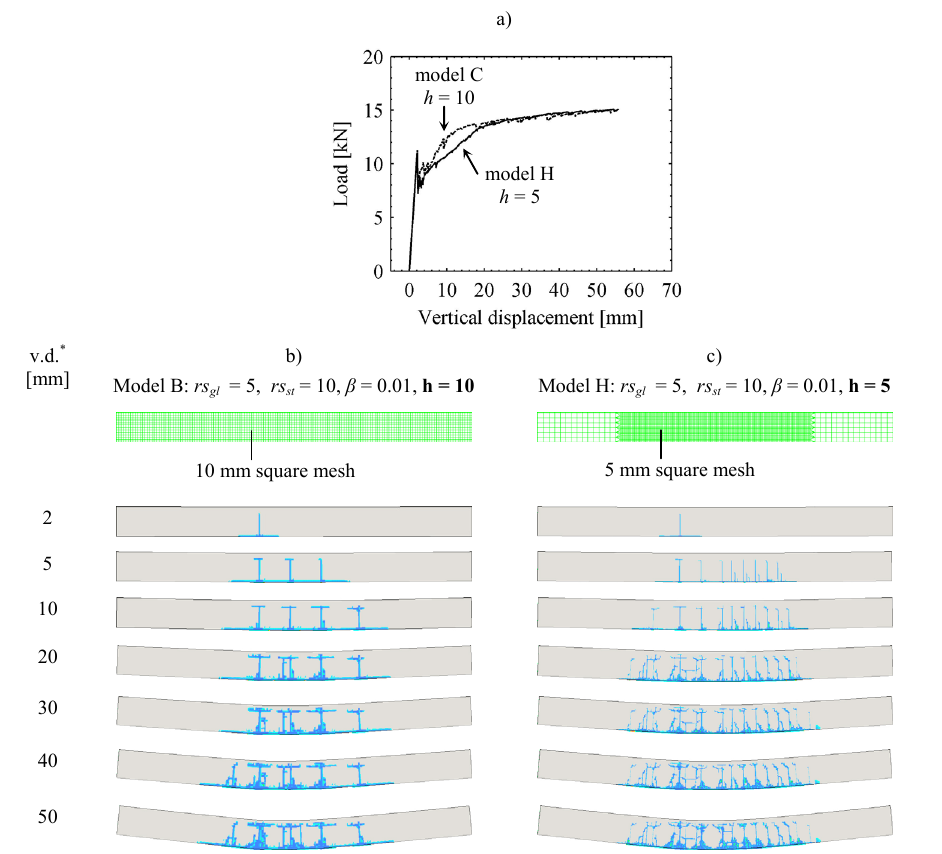
Figure 9: a) Load-displacement diagrams of models C and H with varying mesh sizes; b) contour plot of the reduced E-moduli (crack pattern) of model C; c) contour plot of the reduced E-moduli (crack pattern) of model H; * v.d. = vertical